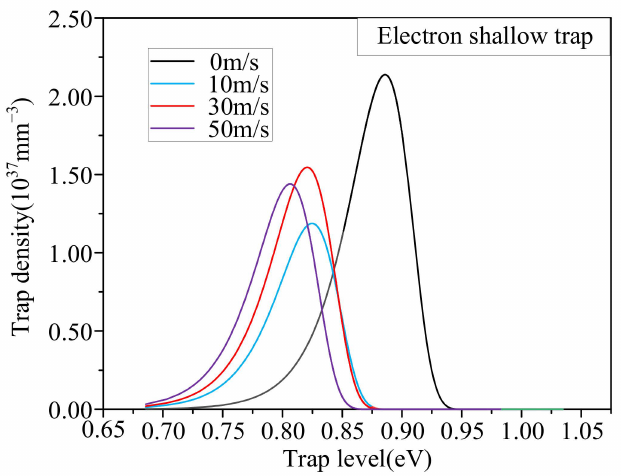
Figure 26. Distribution curve of shallow trap energy level with trap density at different airflow